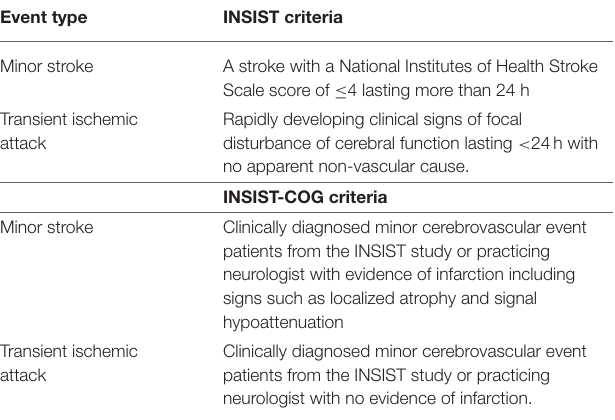
TABLE 1 | Criteria for adjudication of minor stroke and TIA event types in the INSIST and INSIST-COG cohorts. Event type